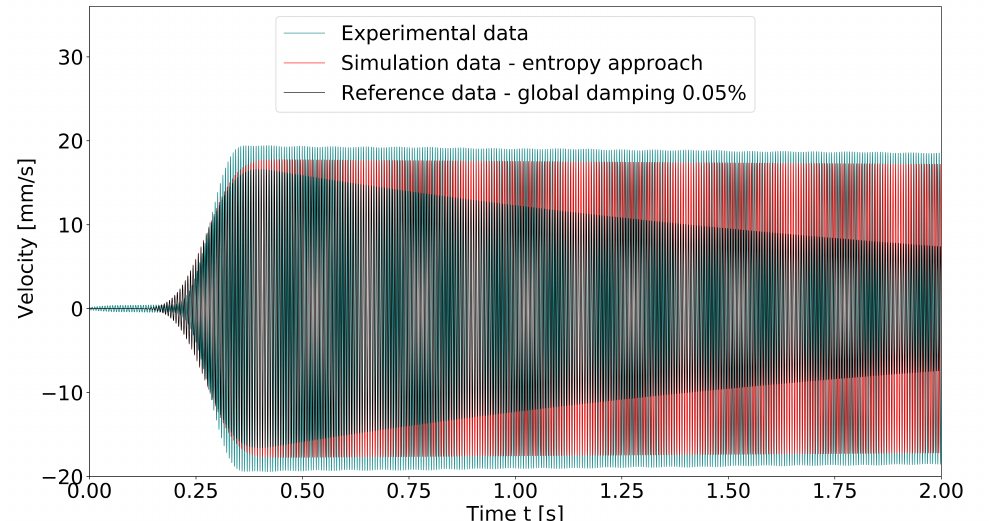
Figure 12. Comparison of velocity time series of impulse-excited plate structure: experiment, sim- ulation with global structural damping and simulation with modal damping. The velocity was measured/analyzed on a corner point of the plate.